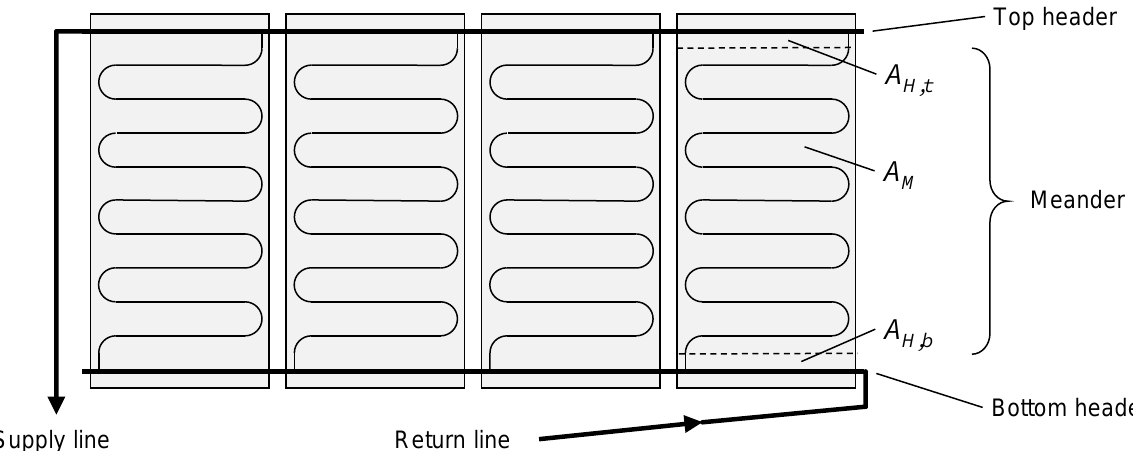
Figure 3. Solar collector array with meander-shaped absorber tubes and integrated header tubes connected in parallel.